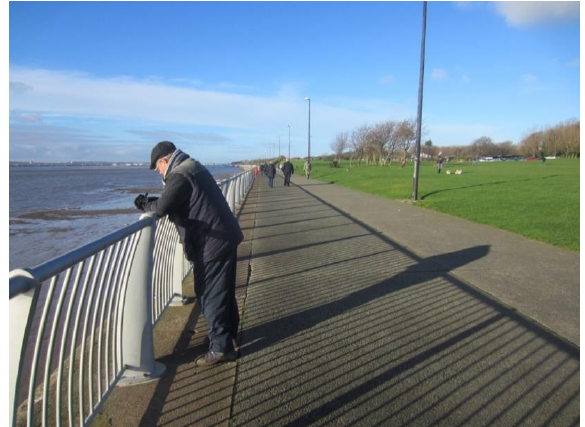
Figure 3. Example of green spaces promoting respect and social inclusion (P17) (Otterspool Promenade, Liverpool).